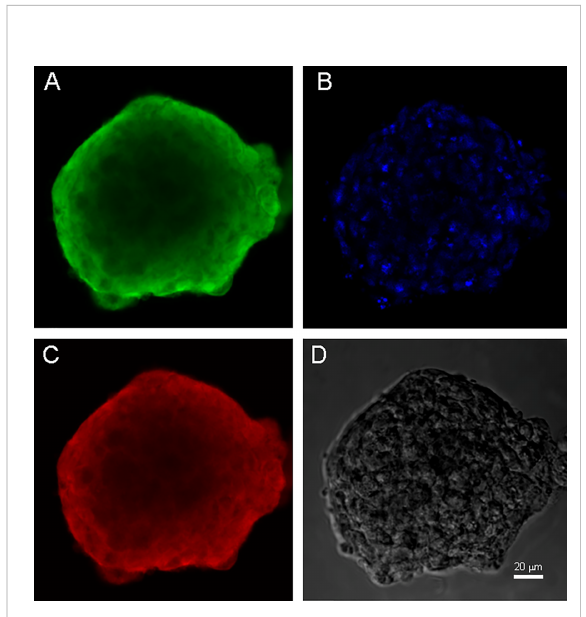
FIGURE 3 Neurospheres of glioblastoma cell culture of GO1. (A) antibody staining for Vimentin. (B) staining for bisbenzimid, (C) antibody staining for Nestin, (D) neurospheres in phase contrast. Scale bar is 20 m